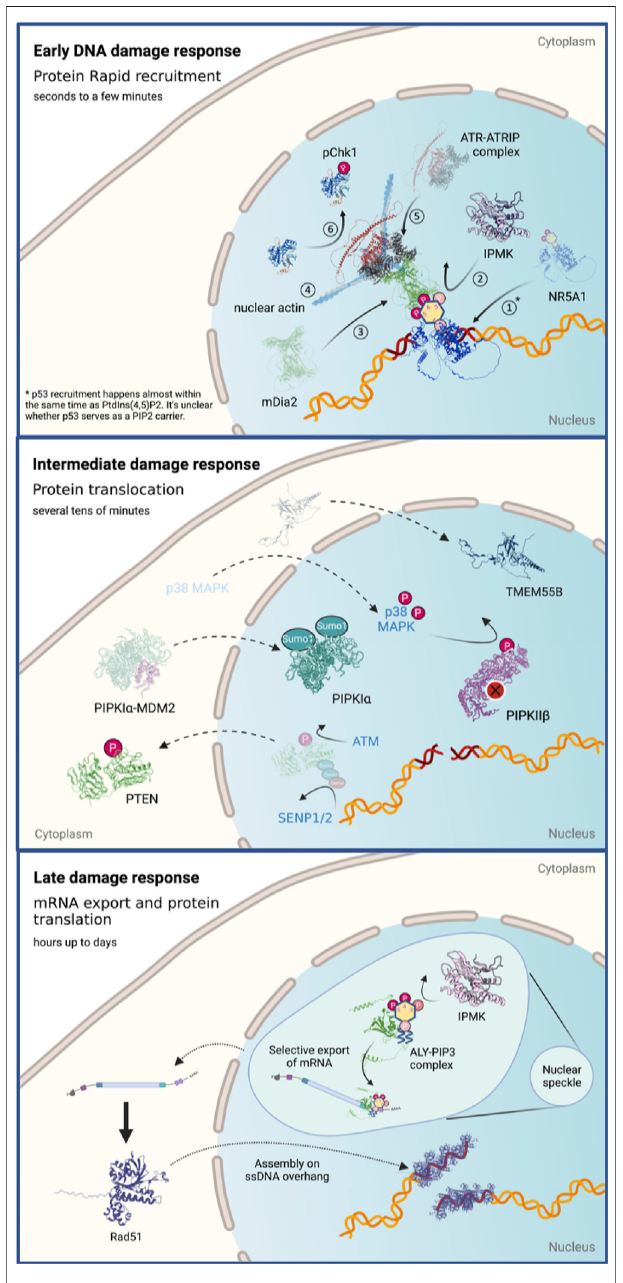
FIGURE 3 | The roles of nuclear phosphoinositides and the regulation of their kinases and phosphatases in response to DNA damage at different time scales. Figures created with